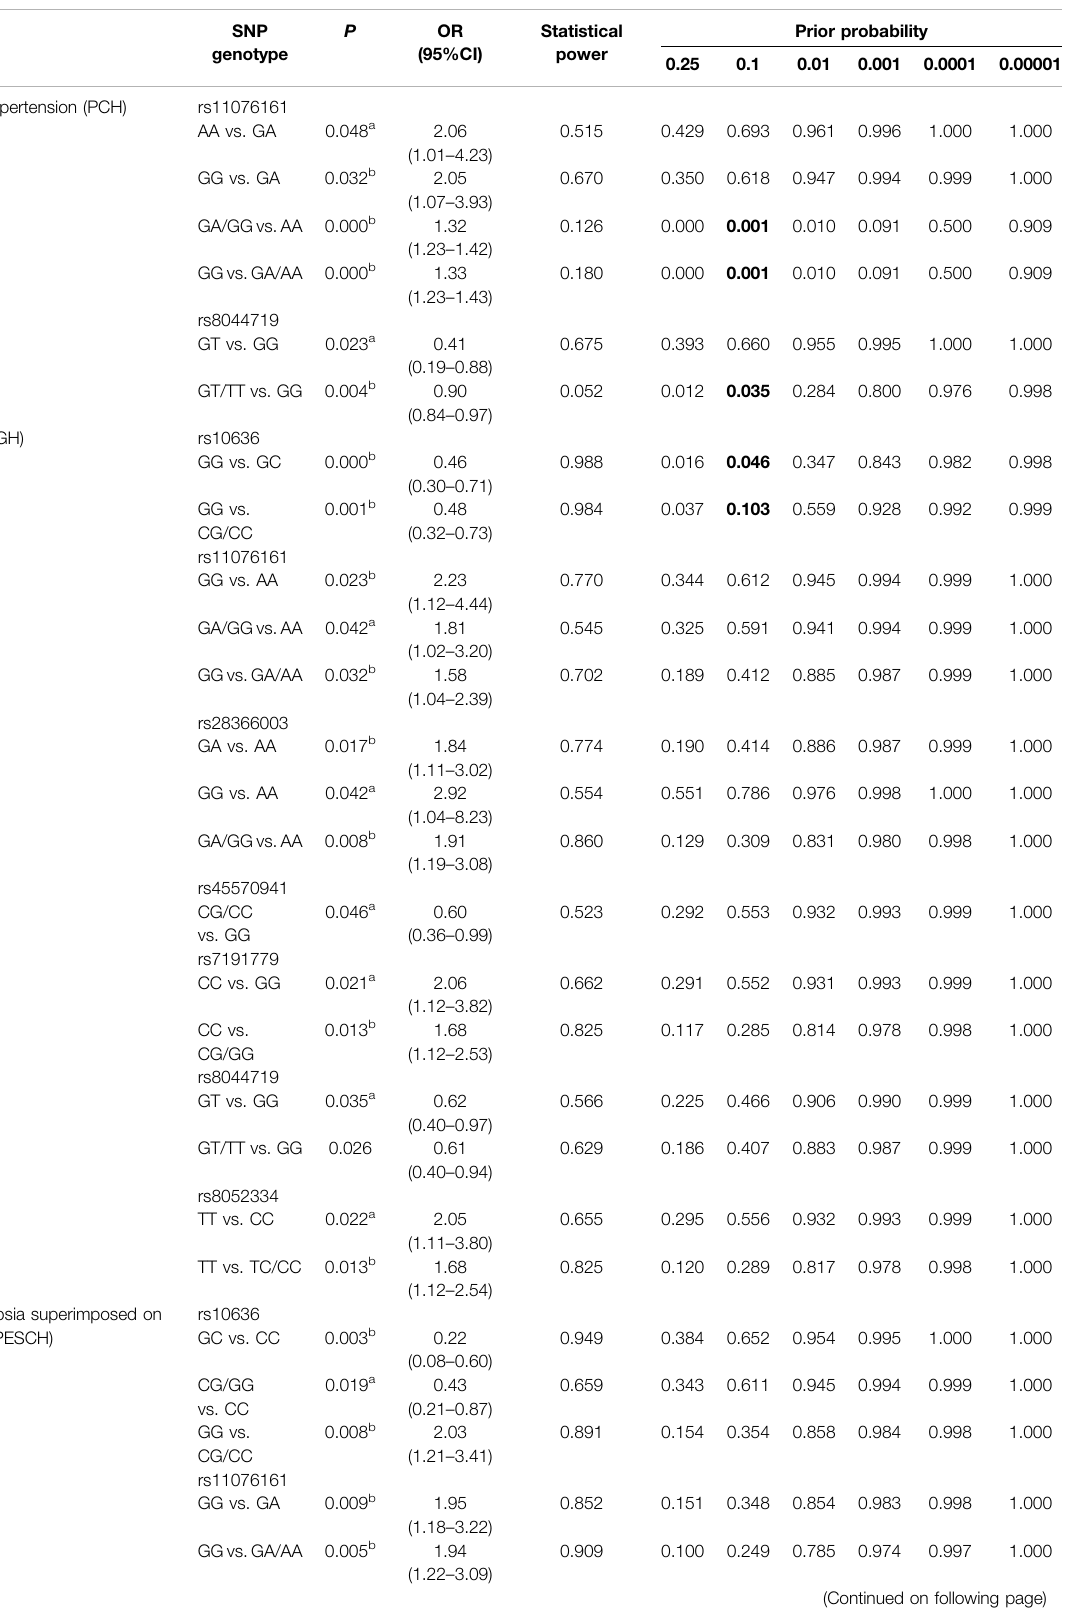
TABLE 4 | False-positive report probability (FPRP) analysis for the association between SNPs in MT genes and the susceptibility of PCH, GH, PE/PESCH, and HDP. Group